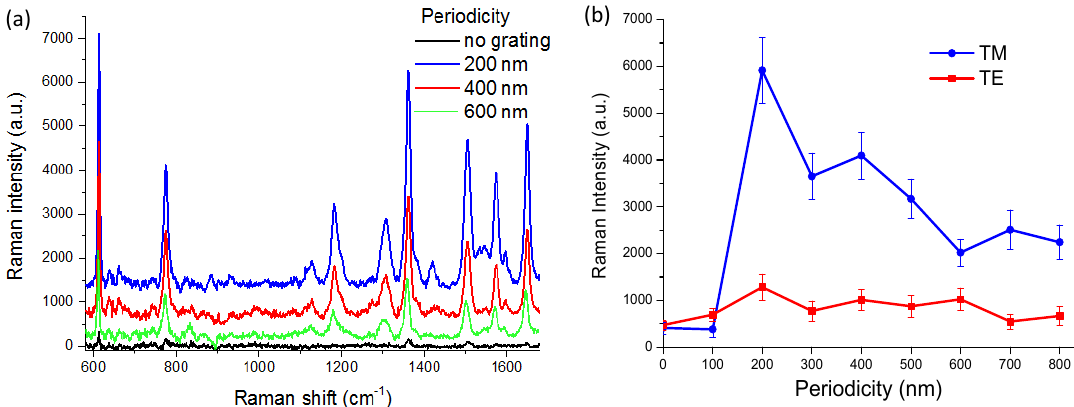
Figure 4. ( a ) Background corrected Raman signal from nonlift-off nanogratings. The spectra are labeled with different color respectively. The black line is the spectrum from a gratingless substrate, which is gold thin film coated flat photoresist (PR) layer (no-grating). The blue line is the spectrum from a 200 nm-period grating. Red line is the spectrum from a 400 nm-period grating. Green line is the spectrum from a 600 nm-period grating. The spectra are vertically shifted for visual clarity. ( b ) The periodicity dependence of Raman intensity for transverse magnetic (TM)- (blue circles) and transverse electric (TE)-polarized (red squares) excitation.